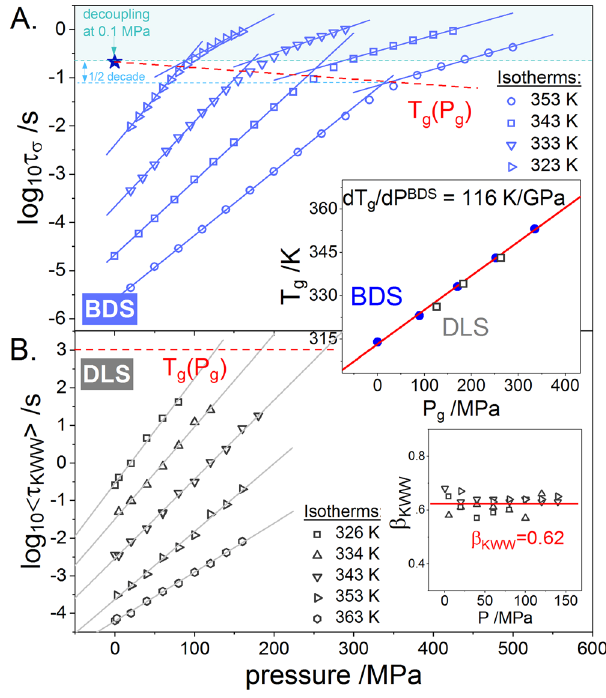
Figure 3. Isothermal measurements of conductivity ( A ) and structural ( B ) relaxation times of ACB-HCl. The insets present the pressure dependence of the T g temperature (upper panel) and of the β KWW parameter (lower